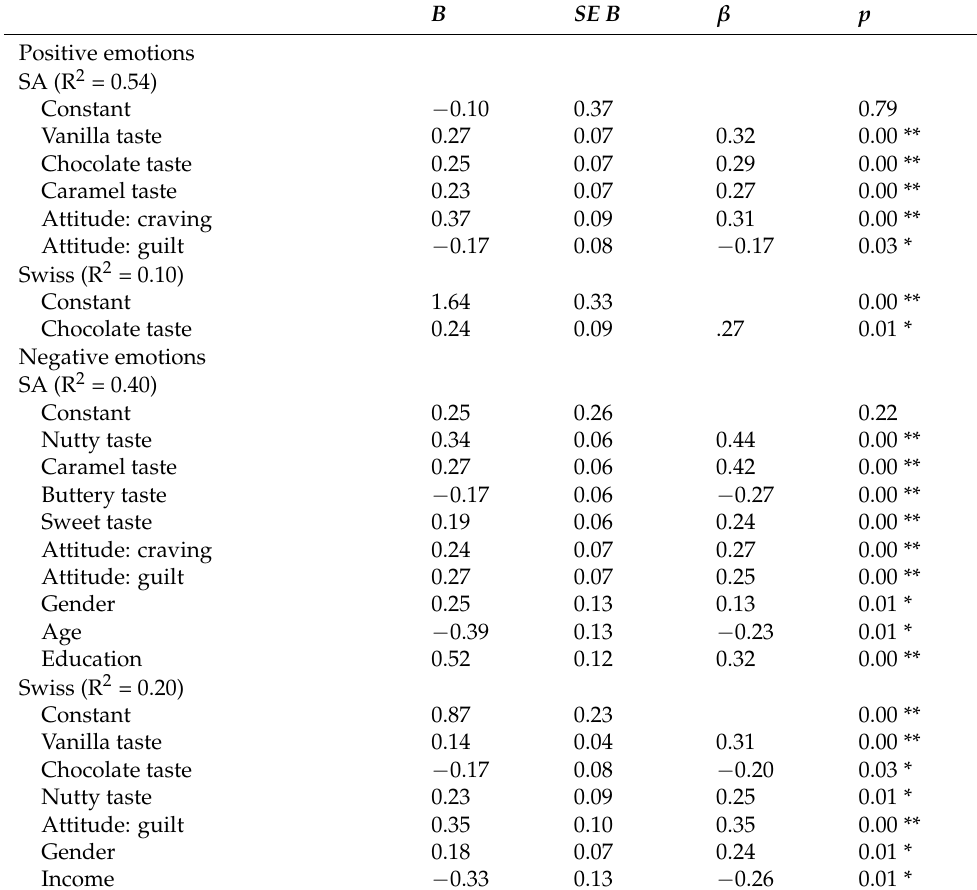
Table 6. Summary of regression analysis for variables predicting consumers’ emotions after biscuit